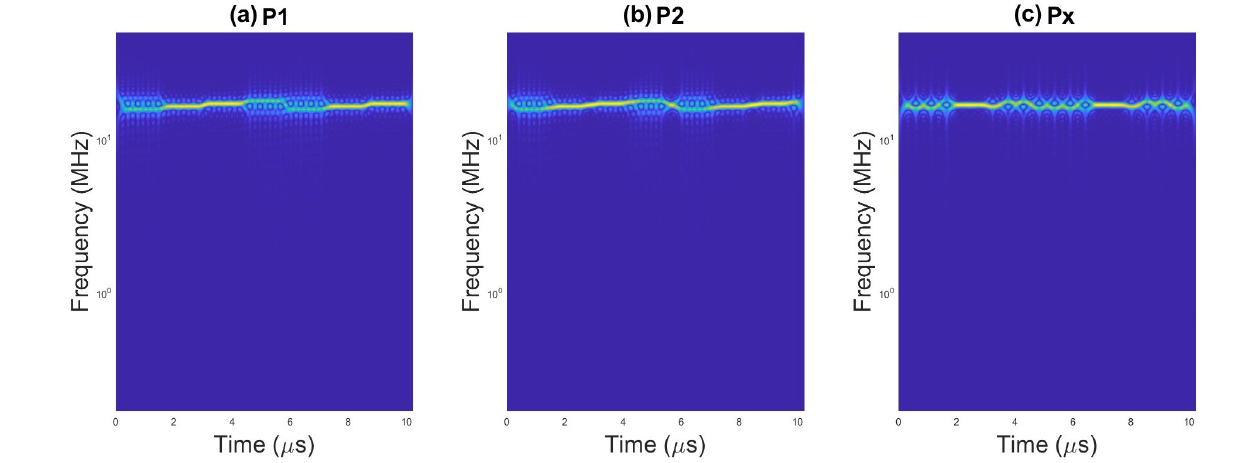
Figure 7. WVD for pulses with ( a ) P1 code, ( b ) P2 code, and ( c ) P x